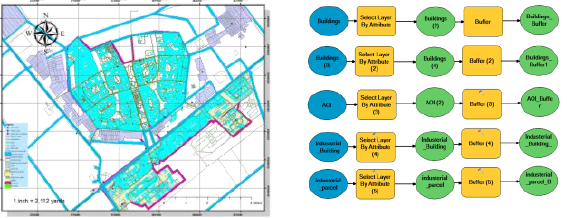
Figure 3 . Information and Communication Technology (ICT)